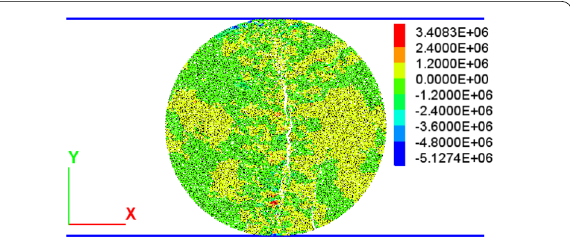
Fig. 20 Horizontal stress state when the water–cement rate was